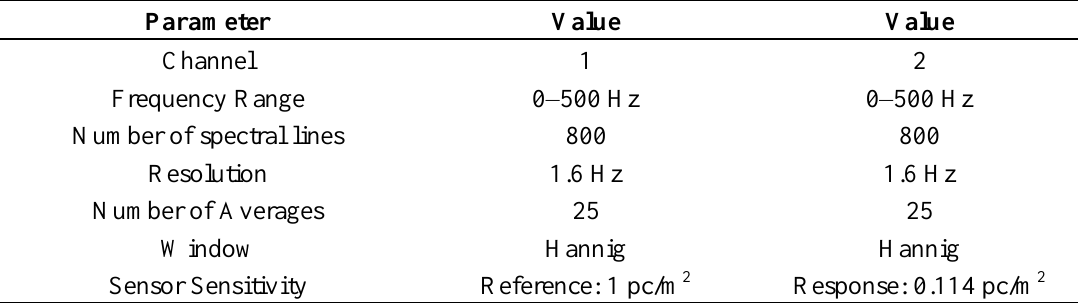
Table 2. ODS Measurement